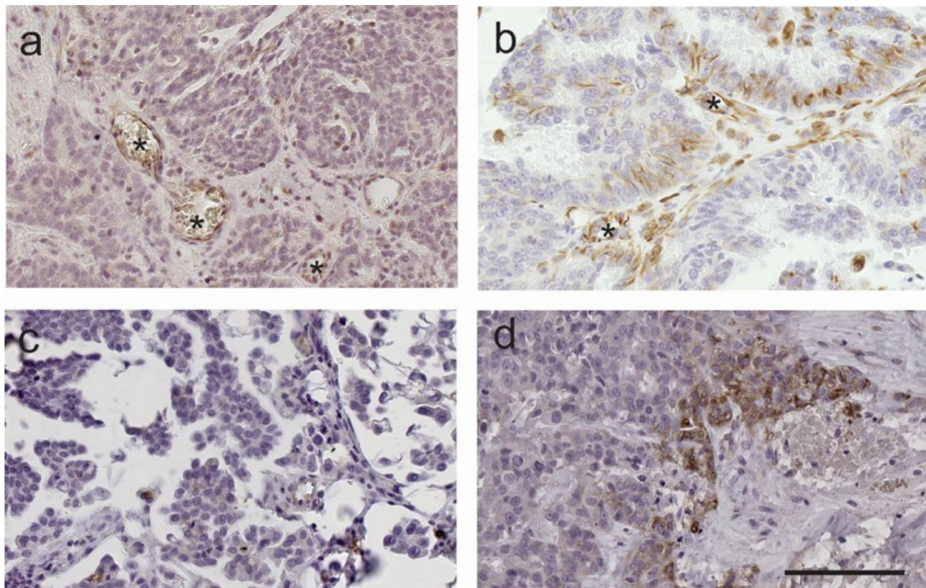
Figure 5. Examples of FSHR and LHCGR immunostaining in serous ovarian cancer cells. follicle-stimulating hormone receptor (FSHR) 323 (1/300 obtained from Prof. Nicolae Ghinea and LHCGR H-50 (1/200, Santa Cruz Biotechnology, Dallas, TX, USA) ( a ) low FSHR 323 immunostaining in cancer cells, ( b ) high FSHR 323 immunostaining in cancer cells, ( c ) low LHCGR immunostaining in cancer cells, ( d ) high LHCGR immunostaining in cancer cells. Scale bar = 100 µ m (all images same magnification). * indicates FSHR positive blood vessels.